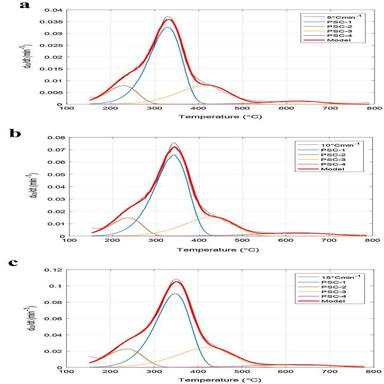
Deconvolution curves regarding the individual pseudo-components devolatilization at the heating rates of 5, 10 and 15 °C min−1 for pyrolysis process of Poplar fluff, using independent parallel reactions model, by optimization procedure.